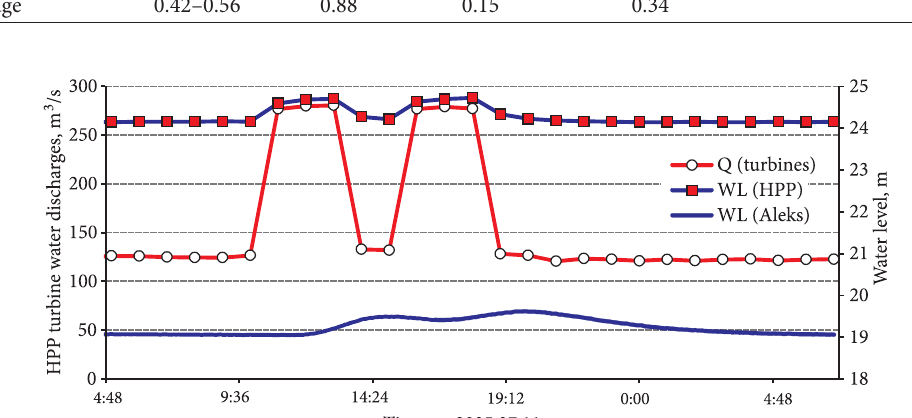
Fig. 5. Dynamics of the Kaunas HPP turbine discharges Q (HE), water levels in the downstream reach of the HPP WL (HPP), water levels at the Aleksotas Bridge WL